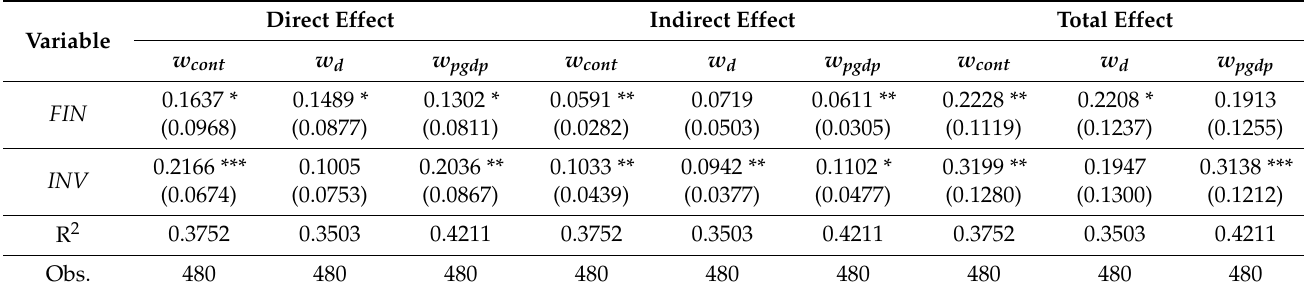
Table 3. Direct, indirect and total effect of the SDM